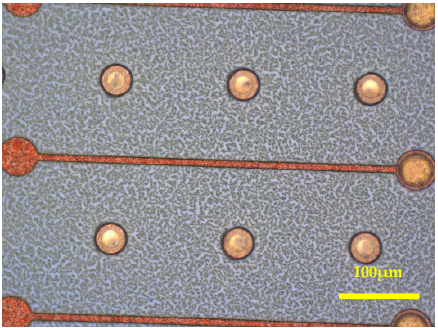
Figure 15. Morphology under metallographic microscopy.